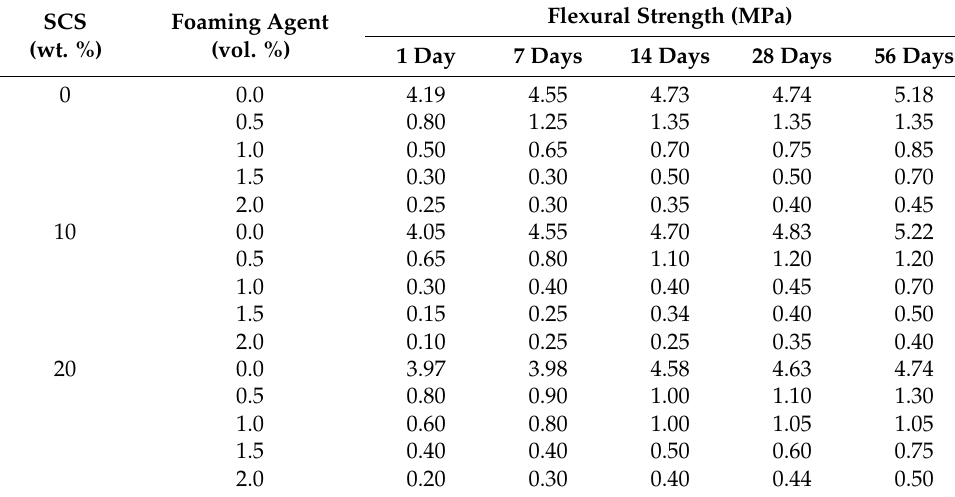
Table 3. Flexural strength development of lightweight